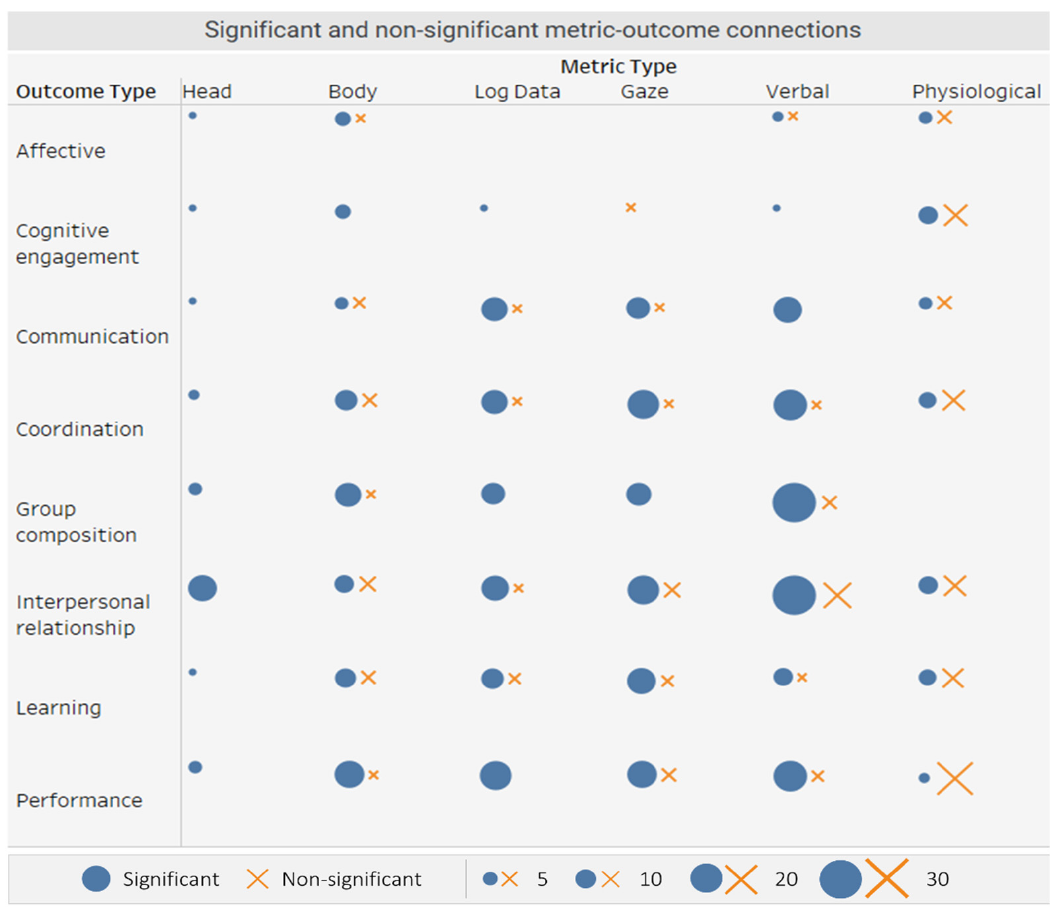
Figure 3. Success of metric–outcome connections. Circles and crosses represent the number of significant and non-significant connections, respectively.